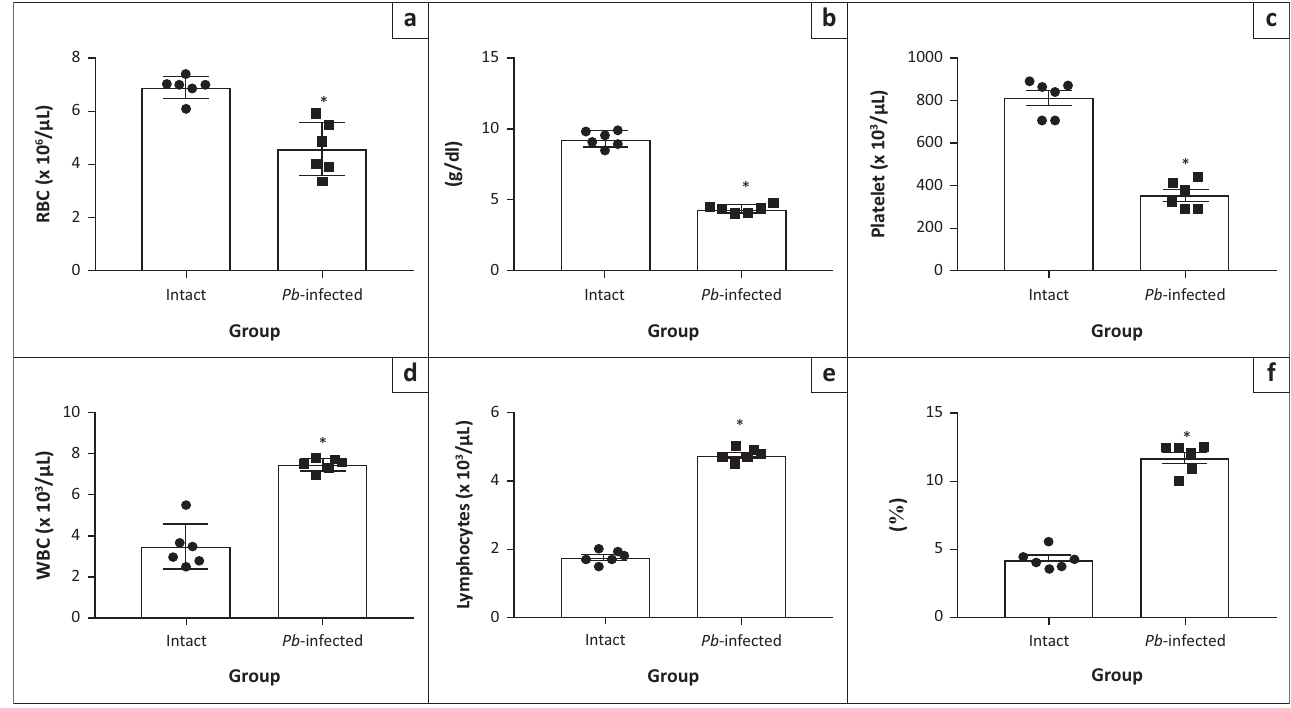
FIGURE 2: The haematological Parameters of Pb - infected and intact (uninfected) mice. (a) Red blood cells count. (b) Haemoglobin level. (c) Platelets count. (d) White blood cells count. (e) Lymphocytes count. (f) Platelet large cell